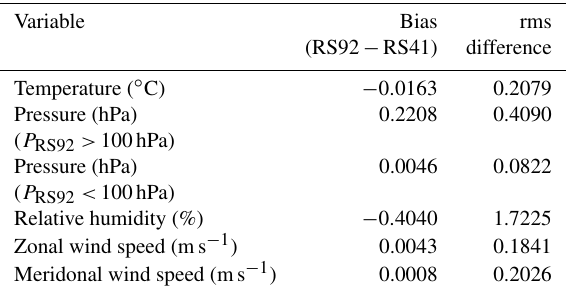
Figure 7. Profiles of dry-bulb and dew point temperature from bal- loon flight no. 3, which was launched on 3 June 2014 at 17:46LT. Dry-bulb temperature for RS92 (cyan) and RS41 (magenta). Dew point temperature for RS92 (blue) and RS41 (red). Table 7. Summary statistics over all sounding flights and heights. The bias difference is defined as RS92 − RS41.